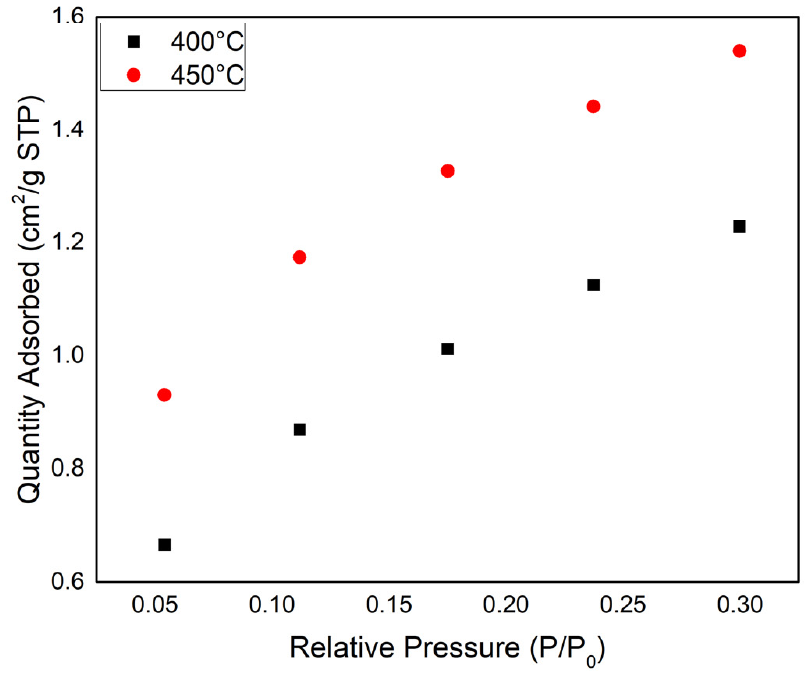
Figure 7. Adsorbed amount of N 2 by in natura biochar at 400 ◦ C and 450 ◦ C. Table 6. B.E.T. analysis for the biochars obtained. Surface Area Pore Volume Pore Diameter Biochar Source (m 2 · g − 1 ) (cm 3 · g − 1 ) (nm) 400 ◦ C 3.98 1.23 1.75 Author 450 ◦ C 4.88 1.56 1.81 Author 400 ◦ C (SAIN) 0.36 Castro [8] 1.99 Castro